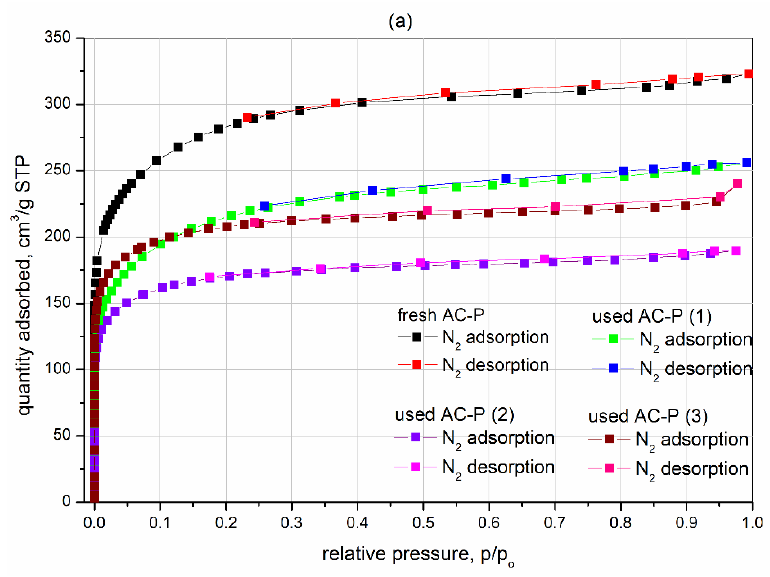
Table 2. Porous properties of the fresh and used impregnated activated carbon AC-P.